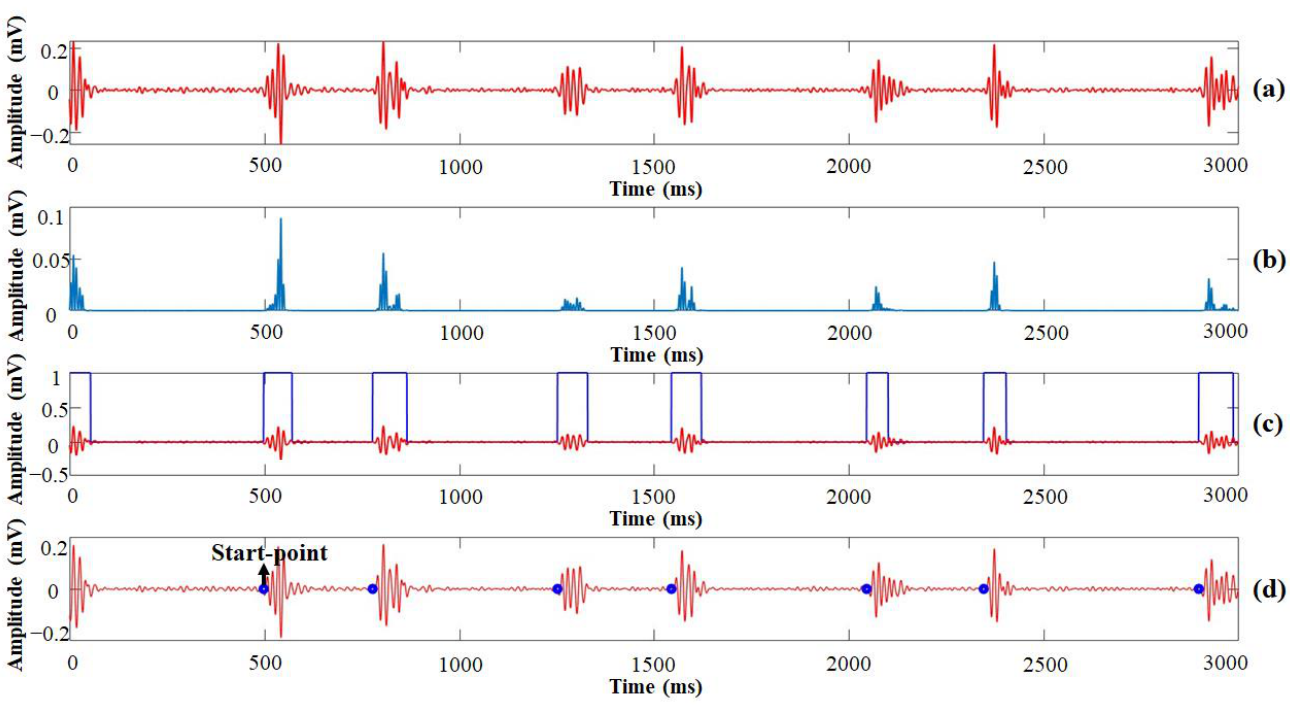
Figure 2. The procedure of heart sound preprocessing to determine boundaries of S1 and S2 heart sounds: ( a ) detected PCG signals; ( b ) smooth Shannon entropy envelope; ( c ) gate signal after envelope thresholding; ( d ) start-point detection.